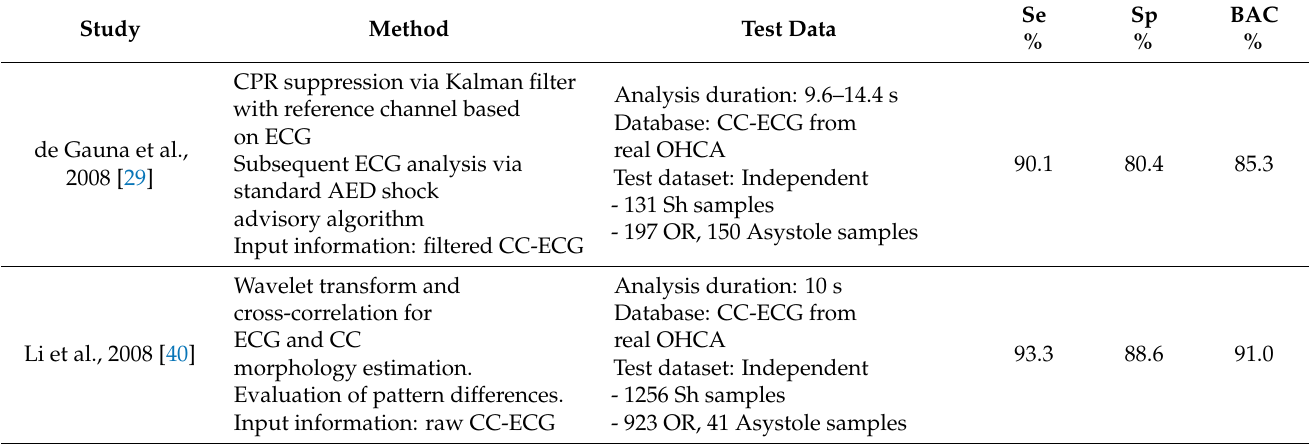
Table 6. Comparison of CNN3-CC-ECG performance to other methods for Sh/NSh rhythm detection during CPR. The results are reported exactly as published in